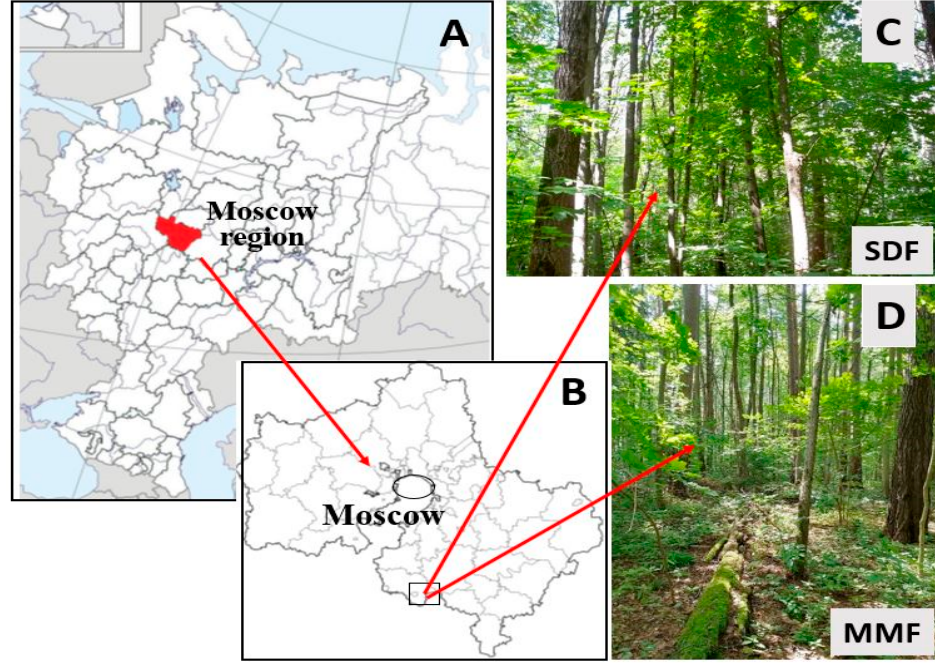
Figure 1. Location of the study sites. ( A )—The European part of Russia; ( B )—Moscow region; ( C )—secondary deciduous forest (SDF); ( D )—mature mixed forest (MMF). Table 1. Basic soil properties (0–10 cm layer) of the forest sites (mean values ± standard error (SE) are shown).